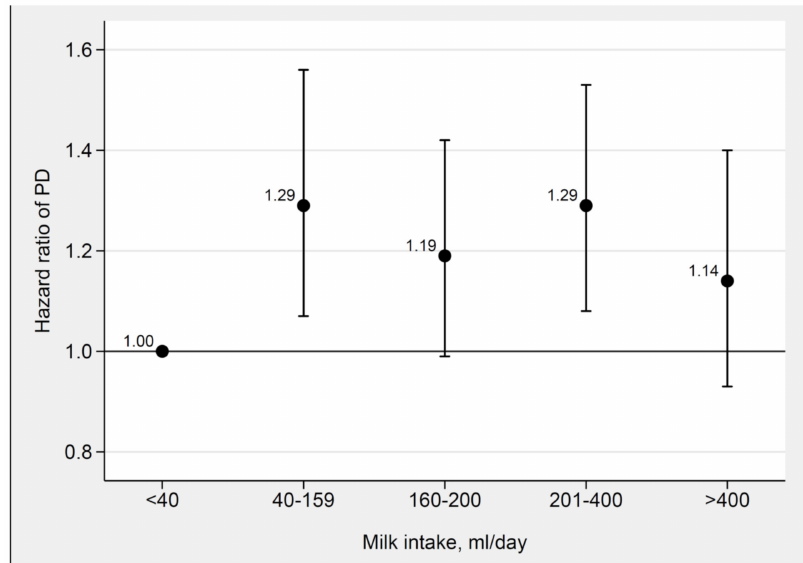
Figure 1. Adjusted hazard ratios for milk intake and incident Parkinson’s disease in the whole study population. Hazard ratios of the associations between milk intake and incident Parkinson’s disease adjusted for sex, smoking, education, alcohol, co ff ee, total energy intake, body mass index, physical activity, living alone, fruit and vegetables, vitamin and mineral supplements, and fermented milk intake using Cox proportional hazards regression with age as time scale in the whole study population (the Swedish Mammography Cohort and the Cohort of Swedish Men).